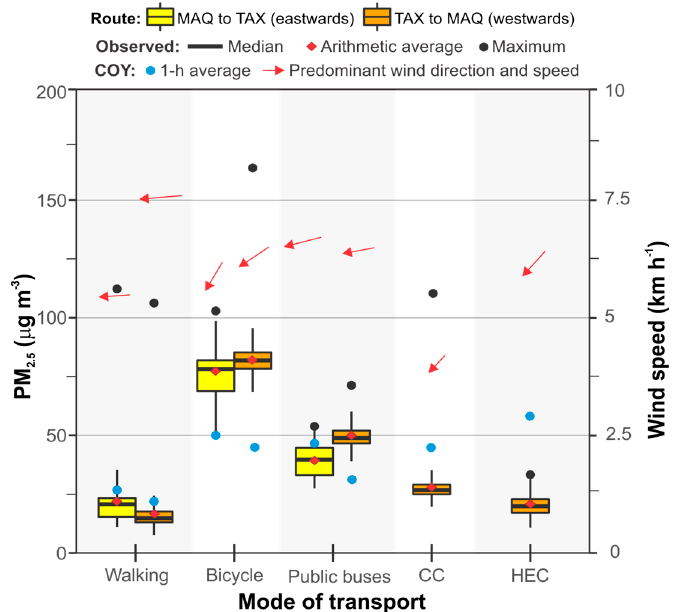
Figure 2. Boxplot of PM 2.5 data recorded along the MAQ Rd in southern MCMA by mode of transport and route during the sampling campaign of November 2014. The eastward public bus journey was made on a trolleybus (yellow) and the westward journey on a diesel bus (orange). Red arrows show wind angle scaled to wind speed i.e., the longer the arrow, the higher the wind speed, as recorded at the COY site.